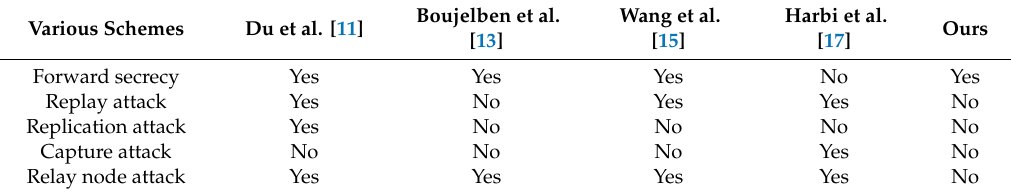
Table 4. Discussion of various schemes about security